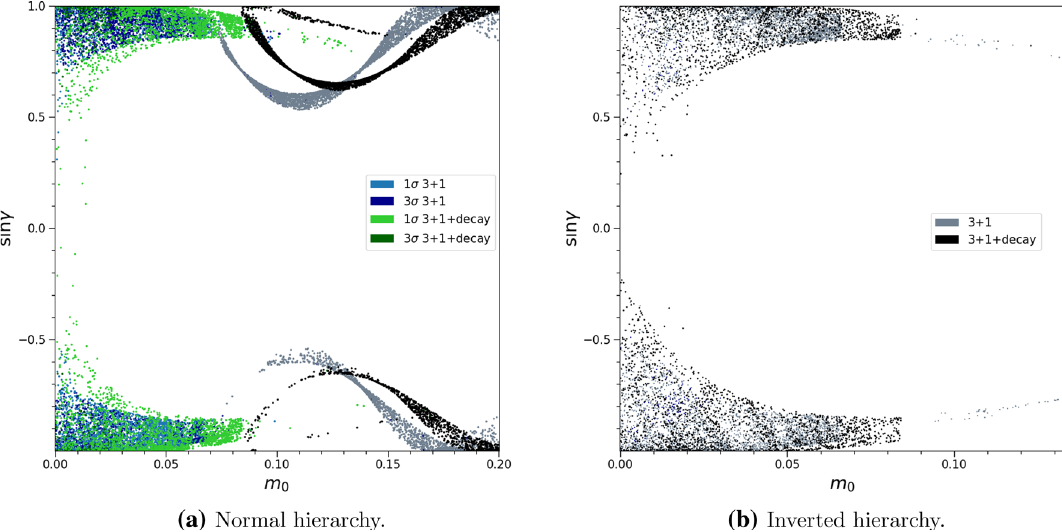
Fig. 5 sin γ as a function of the lightest neutrino mass m 0 . The majority of the positive values for NH correspond to the 3 σ interval for δ CP while the negative ones are within 1